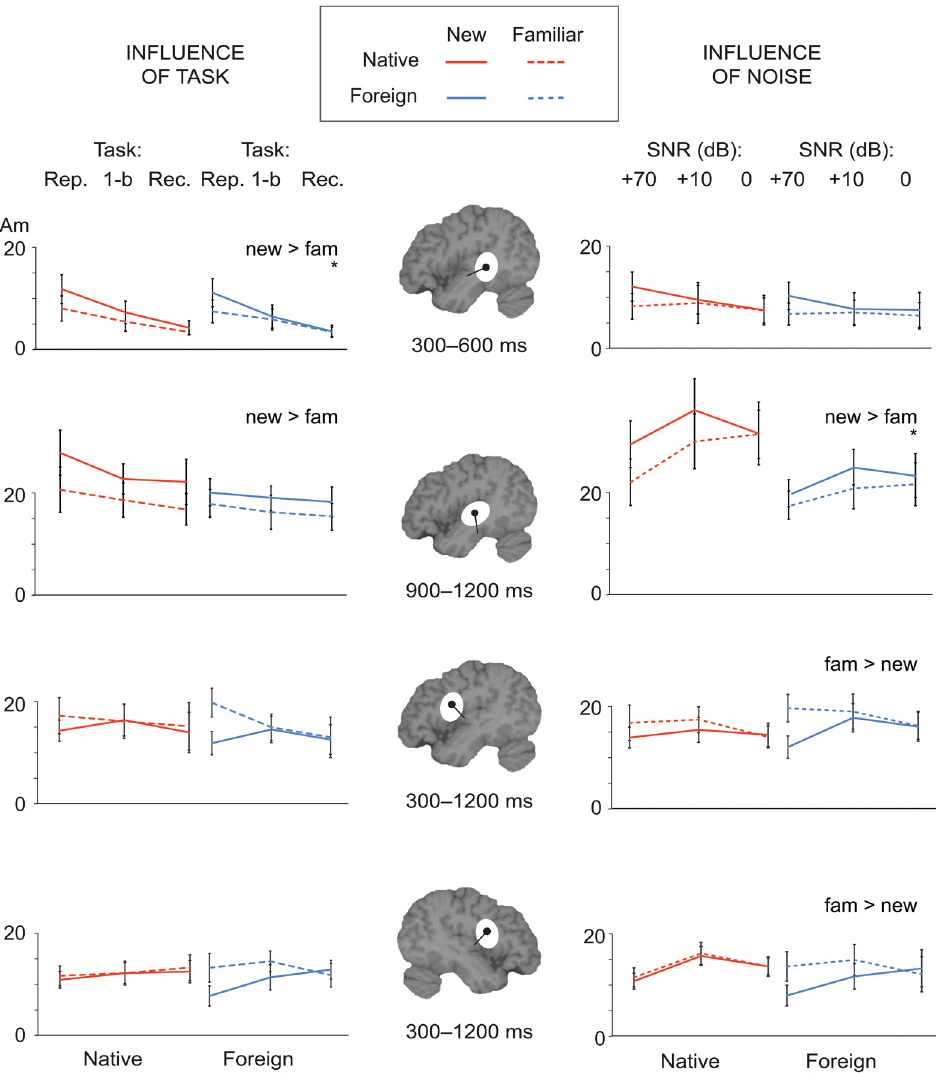
Fig 5. Group-level experimental effects during the post-learning manipulations. Summary of the mean activation strengths for native and foreign language during each of the tasks ( left ; repetition in the learning phase, 1-back control task, recognition) and noise levels ( right ; SNR +70 dB (no noise), +10 dB, 0 dB) in the left temporal and bilateral frontal sources. The time windows are the ones that showed learning effects during the initial learning phase. Statistically significant main effects of stimulus familiarity across experimental conditions (tasks / noise levels) and languages in the ANOVAs are denoted as text beside each plot ( “ new < / > fam ” , p < 0.05). Asterisks ( * ) below the text denote statistically significant interactions of stimulus familiarity and task / noise